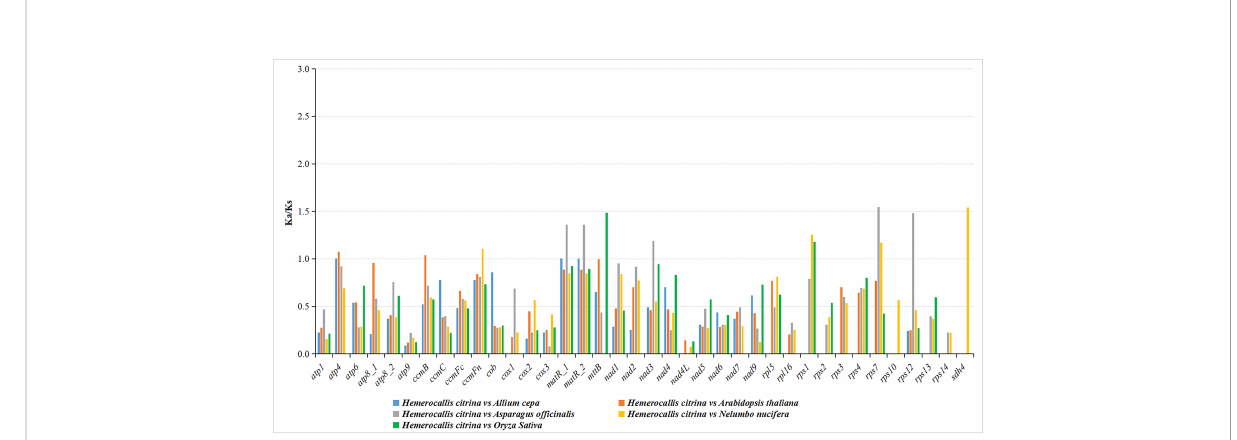
FIGURE 4 Comparison of the Ka/Ks ratios for PCGs in H. citrina and four other